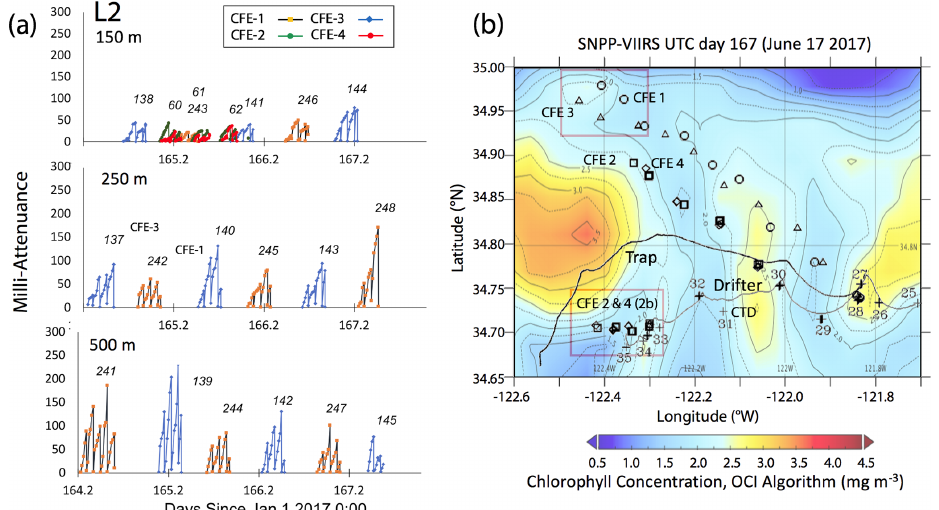
Figure 5. (a) Raw attenuance time series for all CFEs deployed at L2. See Fig. 2 for deployment context. Italicized numbers are the dive numbers corresponding to the data. The mATN time series scales with flux as timing is constant. (b) Map showing deployment and trajectories of CFEs, CTD station locations, and tracks of the productivity drifter and sediment trap array during the intensive studies at L2. CFE-1–4 are indicated by circle, square, triangle, and diamond symbols, respectively. The overlay is the SNPP VIIRS chlorophyll field for 17 June 2017 during the later stages of sampling at this location.